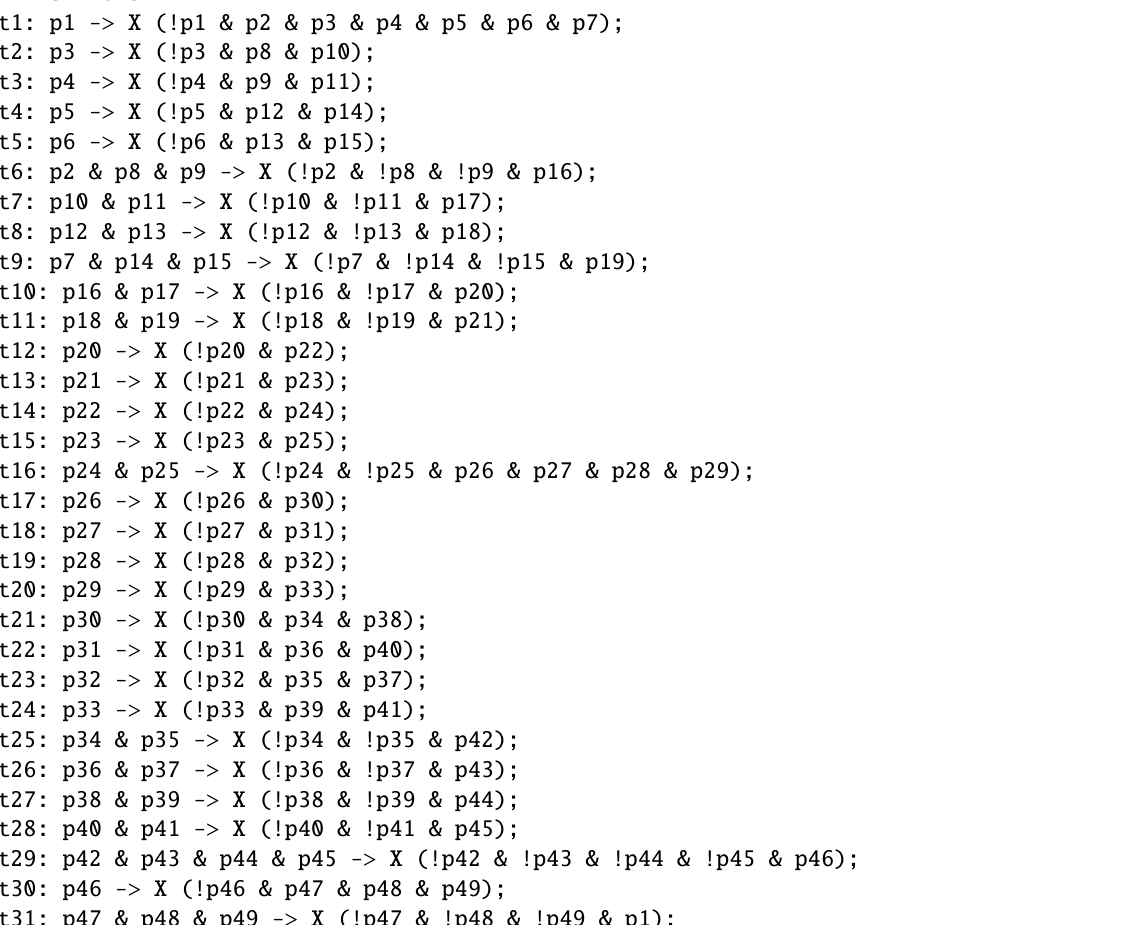
Listing 1. Rules in the rule-based logic model (RBLM) of the Petri net from Figure 5.